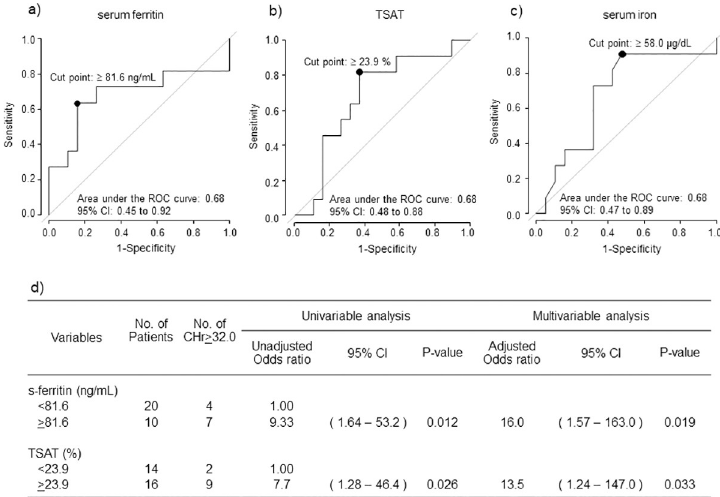
Fig 3. CHr levels on Day 28 and iron status on Day 0. ROC curves of (a) serum ferritin, (b) TSAT and (c) s-Fe on Day 0 for CHr � 32.0 pg on Day 28. The respective cutoff values for s-ft, TSAT and s-Fe were at least at least 81.6 ng/ mL (sensitivity 84.2%, specificity 63.6%, AUC 0.68, 95% CI 0.45–0.92), 23.9% (sensitivity 63.2%, specificity 81.8%, AUC 0.68, 95% CI 0.48–0.88) and 58.0 μ g/dL (sensitivity 52.6%, specificity 90.9%, AUC 0.68, 95% CI 0.47–0.89), respectively. (d) Logistic model analysis with CHr � 32.0 pg as the